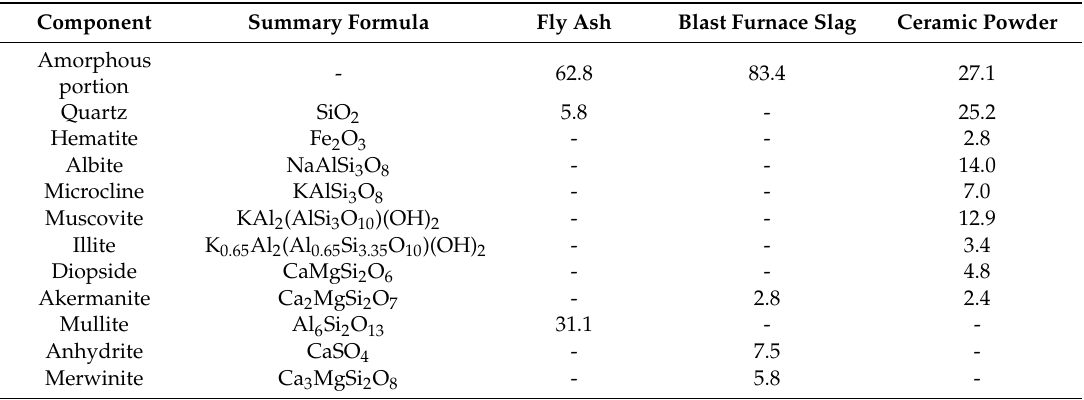
Table 2. Phase composition of used additives